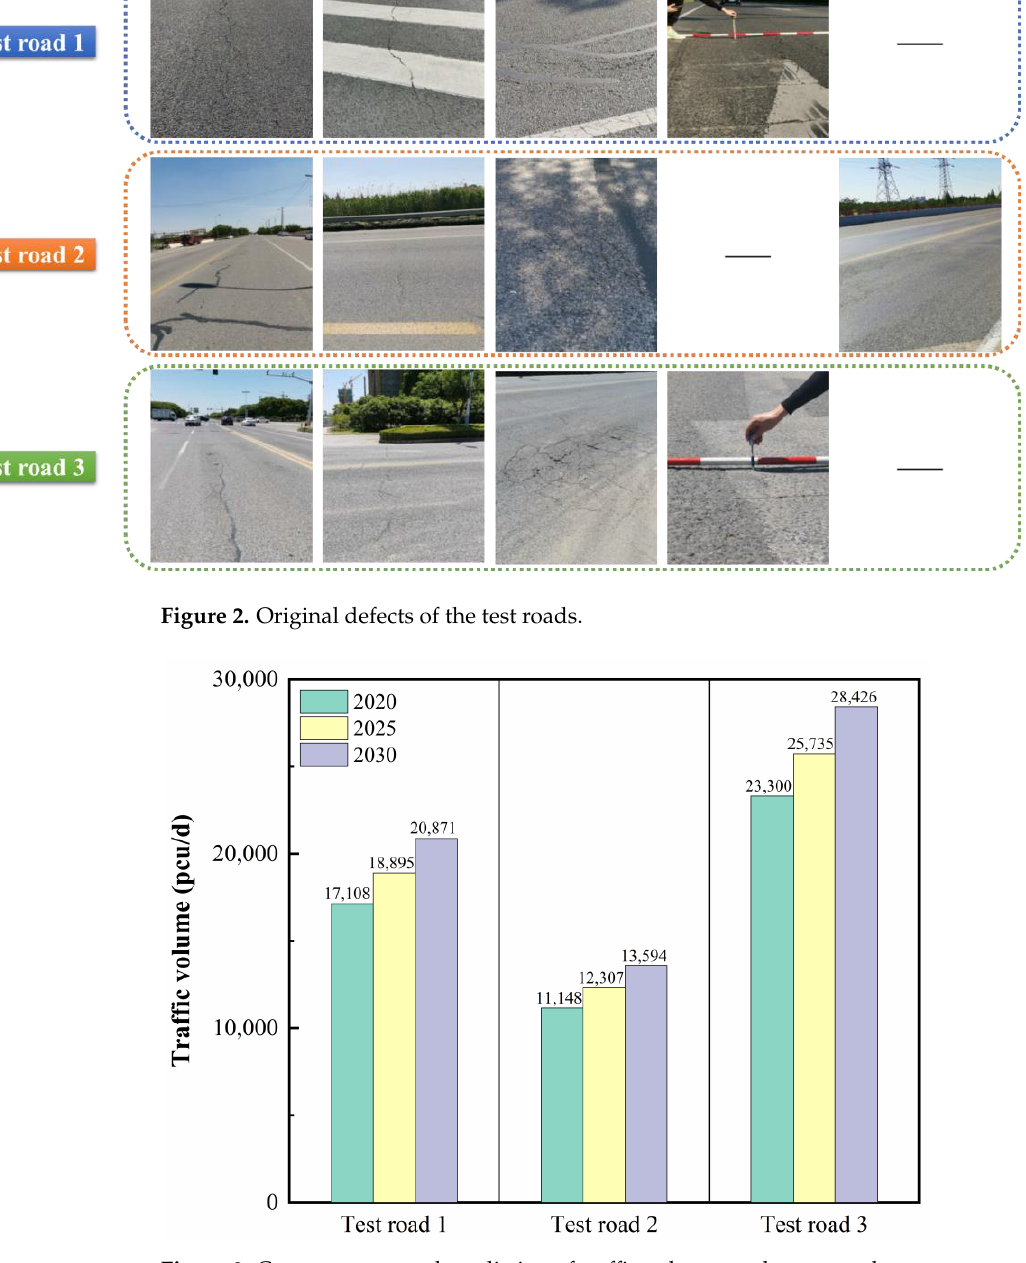
Figure 3. Current status and prediction of traffic volume on the test roads.